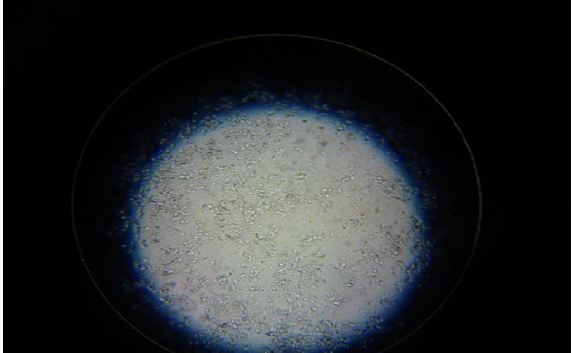
Figure, 5: Eosin-Nigrosin stained sample green arrow denoted.